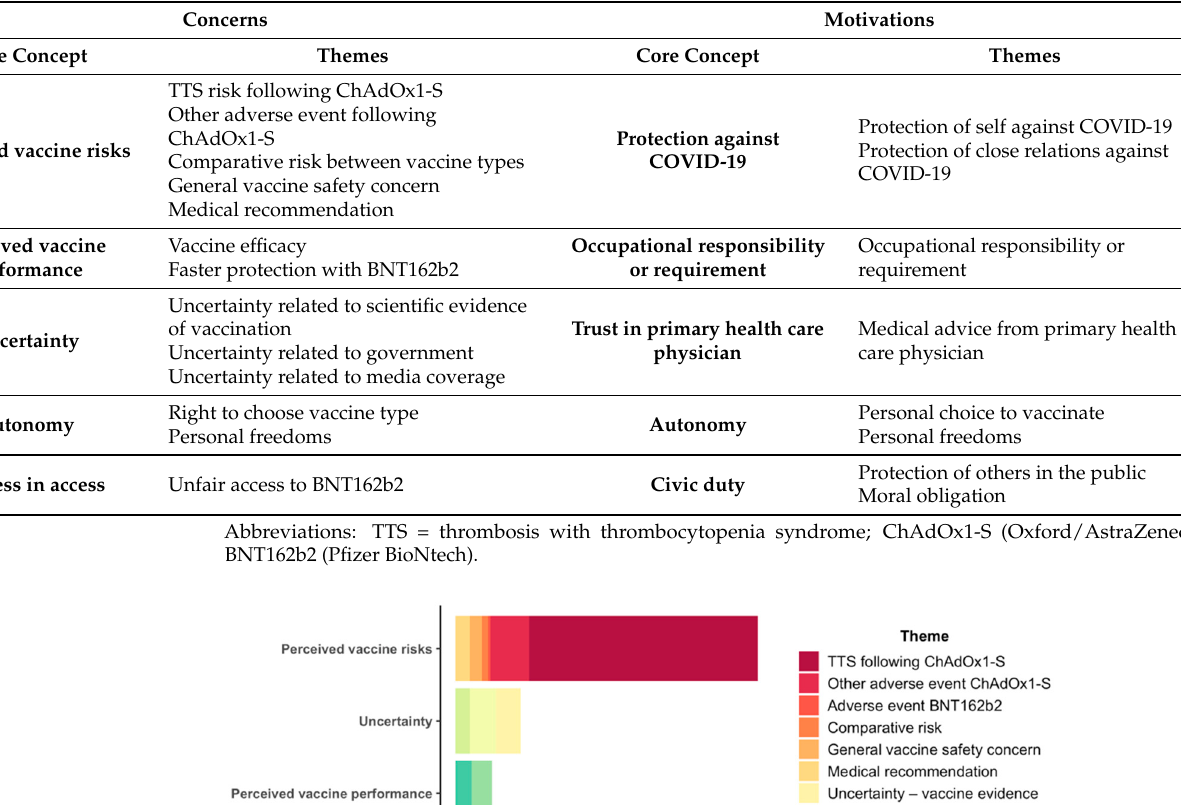
Table 2. Concerns and motivations associated with COVID-19 vaccination.